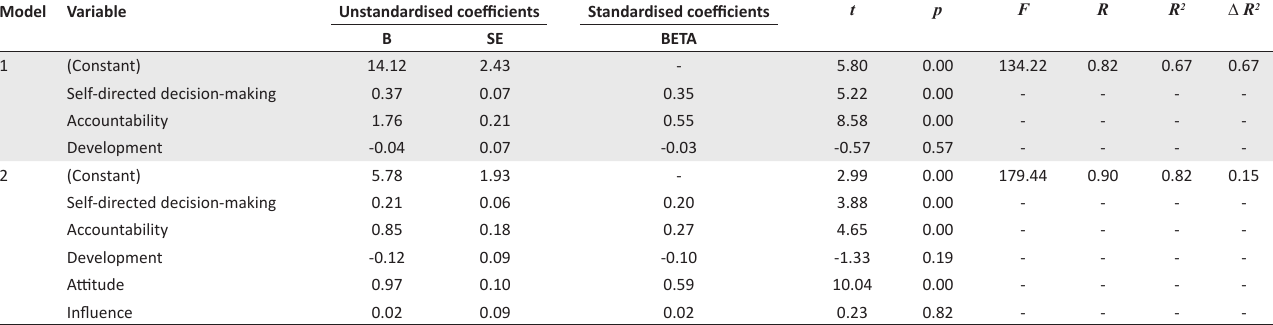
TABLE 4: Multiple regression analysis with loyalty as dependent variable with leader empowering behaviour and psychological empowerment as independent variables. Model